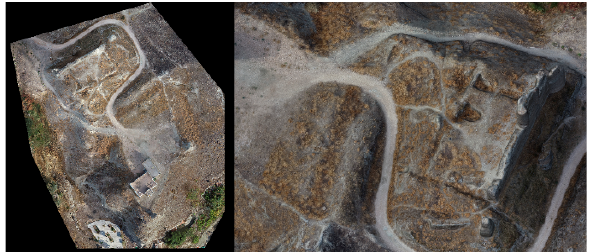
Figure 6. Photogrammetric survey made with RPAS/drone over the medieval castle of Fuentidueña (Spain). On the left: high- resolution orthoimage. On the right: 3D model. This survey was done with the aim of identifying damages, erosion, walls